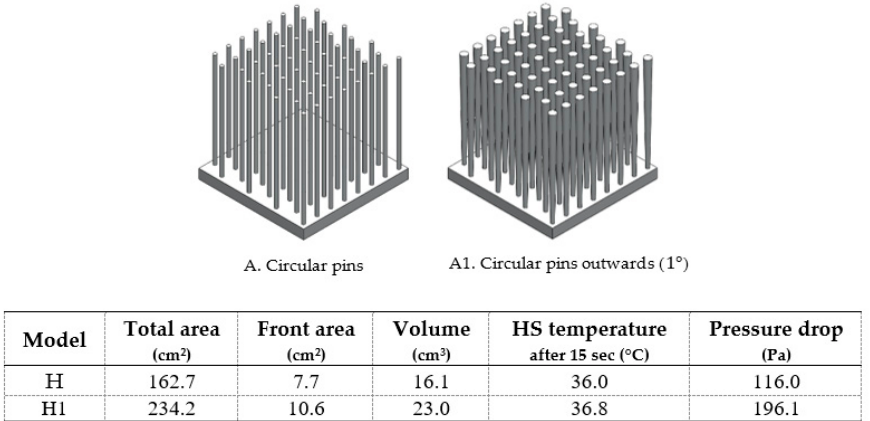
Figure 14. Comparison between circular pins (A) and circular pins outwards (A1).